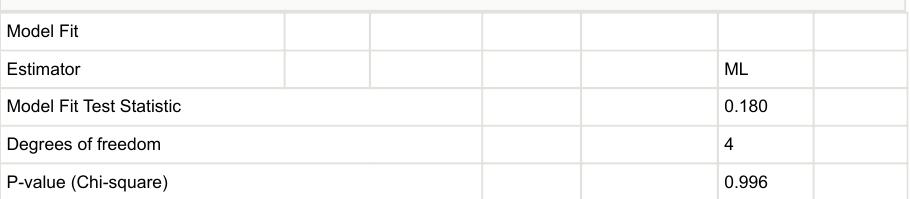
Select results for model selected for interpretation, Model